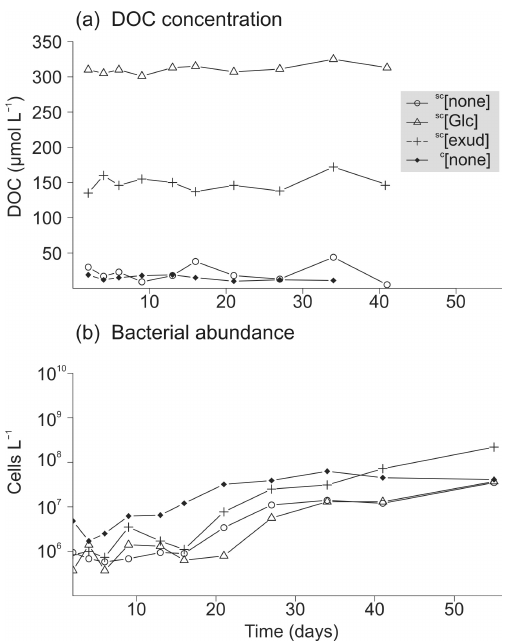
Figure 4. Control samples: DOC concentration and bacterial cell abundance during the incubation